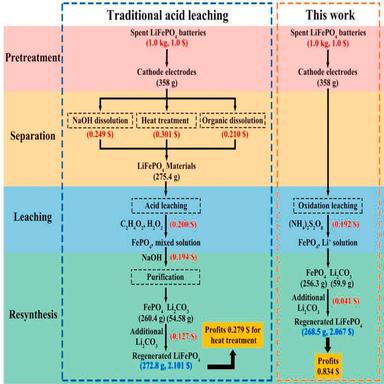
Economic analysis and technology complexity comparison of the entire process for regenerating cathode materials from spent LiFePO4 batteries via traditional acid leaching and (NH4)2S2O8 oxidation leaching.